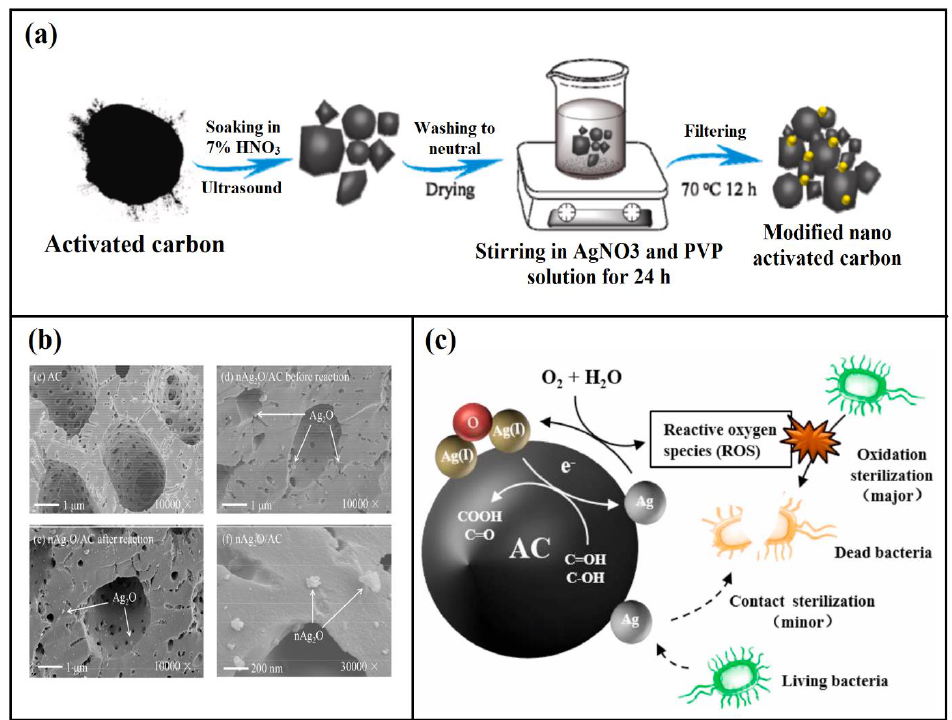
Figure 5. Modified activated carbon for water disinfection; ( a ) schematic illustration of the fabrication process, ( b ) SEM images showing the pore size and silver nanoparticles attachments and ( c ) the sterilization mechanism of modified activated carbon. Reprinted with permission from Ref [81], 2022, Elsevier.